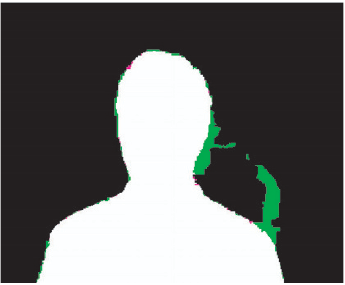
Figure 12: Plot of the segmentation errors, for COST AM 5.1.